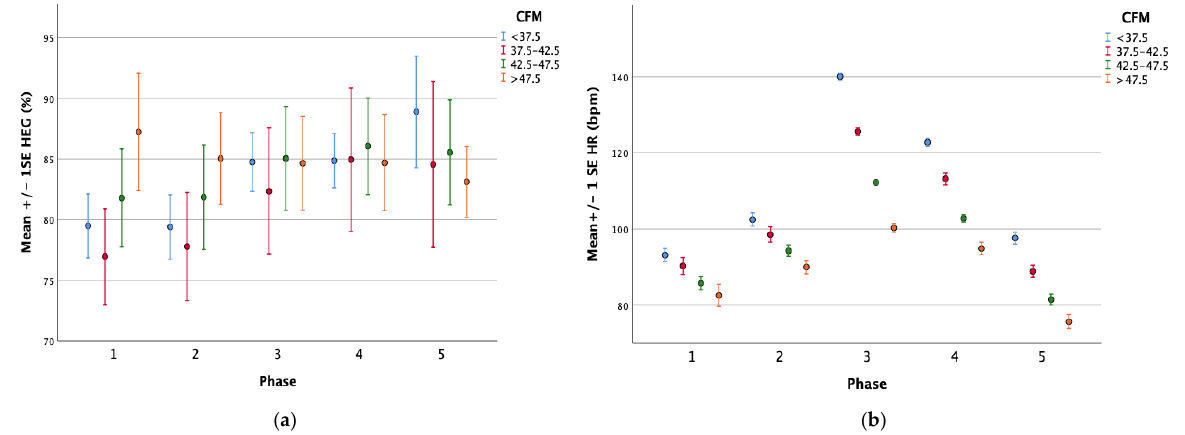
Figure 1. Changes in HEG ( a ) and HR ( b ) across session phases in the four groups. CFM, cardiac force meter; HR, heart rate; HEG, hemoencephalograph. Phase 1, baseline; Phase 2, warm up; Phase 3, submaximal walking exercise; Phase 4, cool down; Phase 5, recovery. ( a ) Changes in HEG between session phases. ( b ) Changes in HR between session